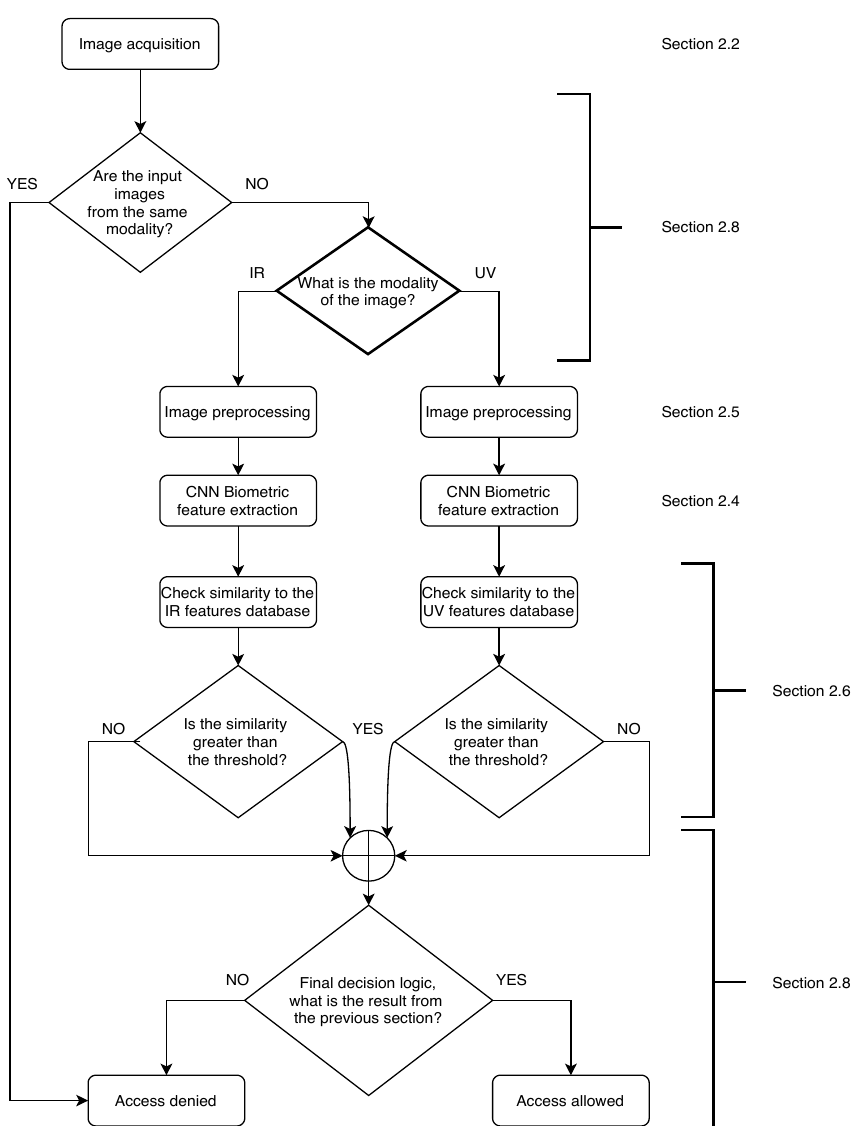
Figure 1. Block diagram with an overview of the system workflow that represents the verification scenario where we minimize false